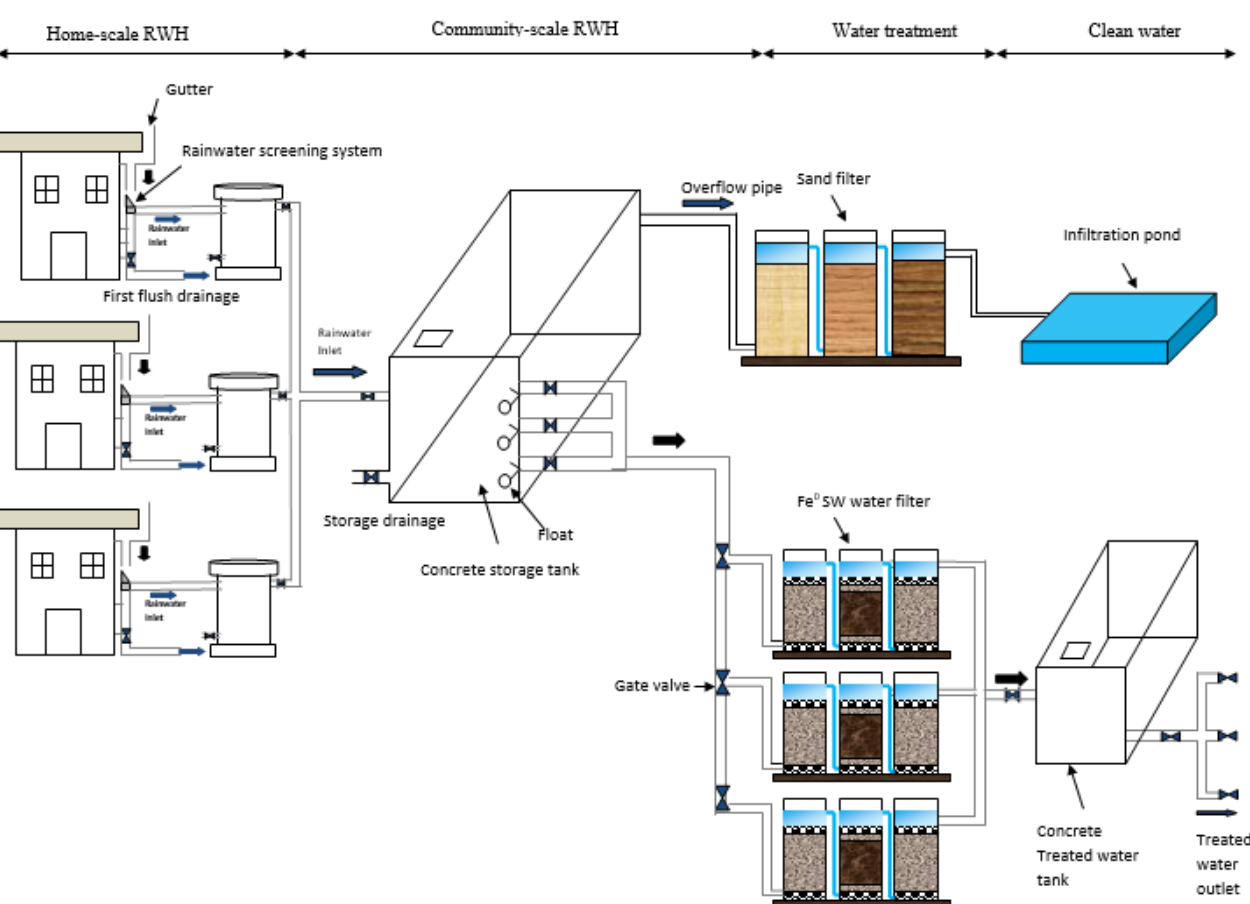
Figure 11. Configuration of a community rainwater harvesting system with a water treatment station. Community-scale water reservoirs are designed to collect overflows from cisterns and tanks from individual households and farms. Overflow from the community tank is directed to infiltration devices (e.g., ponds and wells). Fe 0 SW filter represents a sand filter amended with steel wool (Fe 0 SW) [104] .